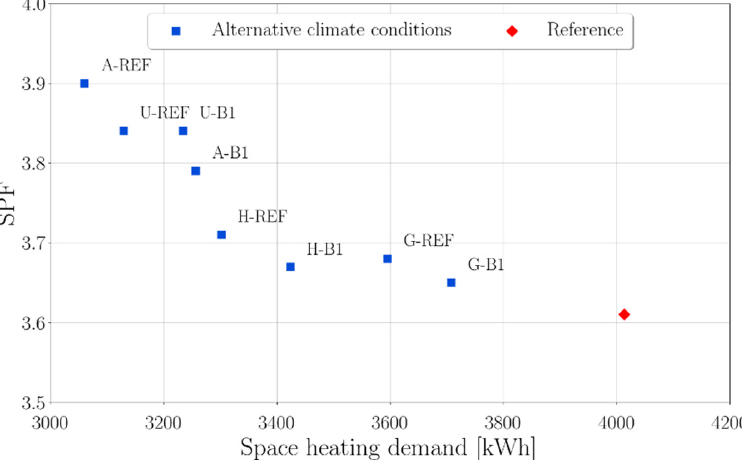
Figure 24. Seasonal Performance Factor ( SPF ) versus the space heating demand for different climate conditions. With exception of the climate conditions, the cases are identical to the reference case.